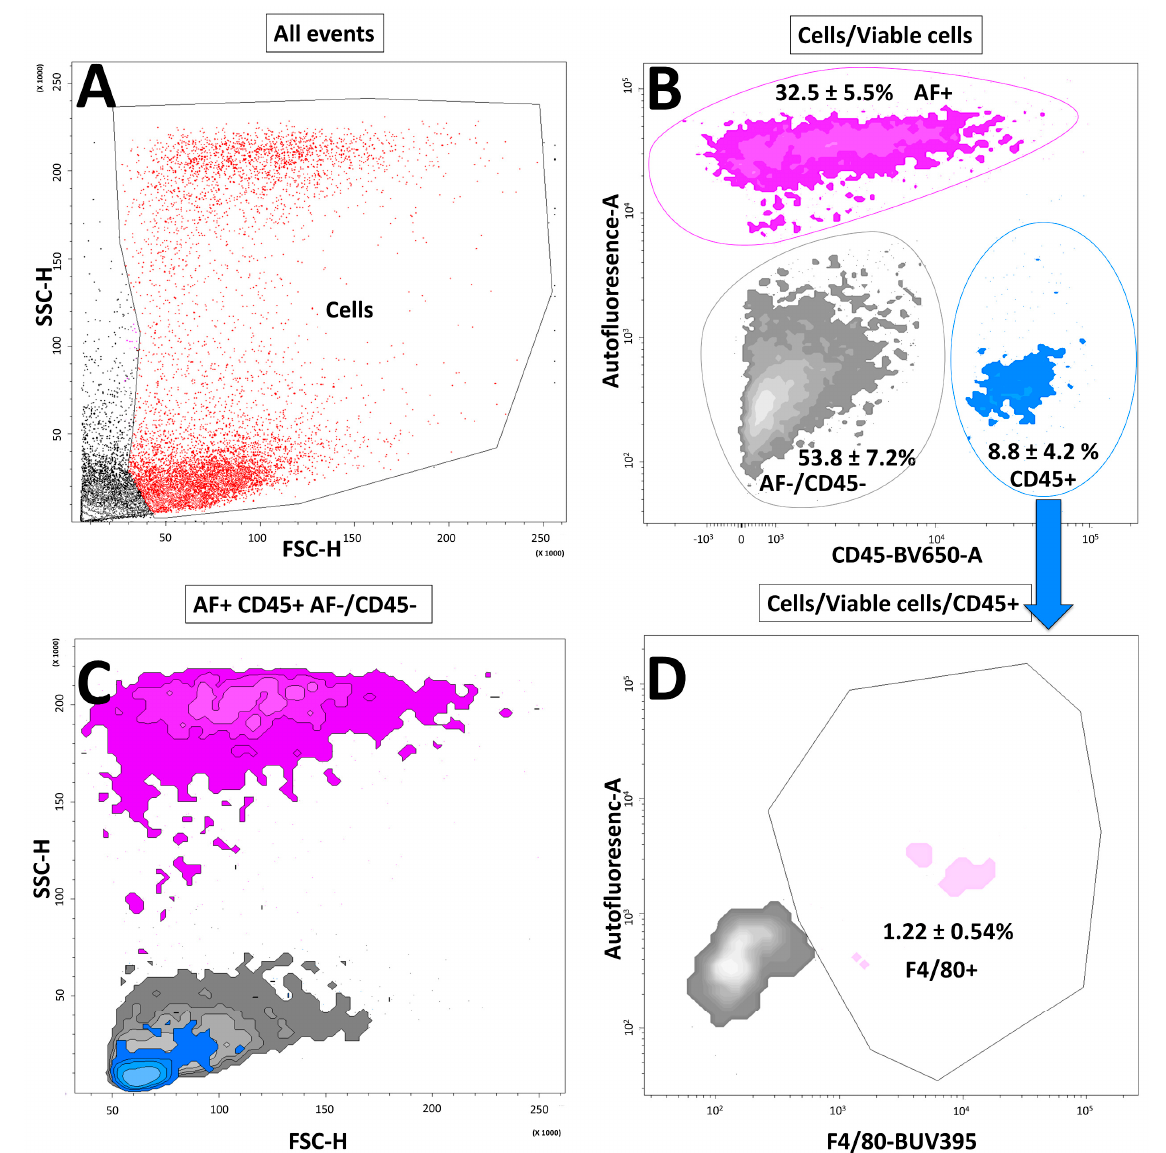
Figure 3. Flow cytometry characterization of isolated hepatic stellate cells. ( A ) Cell morphology allowing to gate cell populations. SSC: side scatter; FSC: forward scatter. ( B ) Selected cells/viable cells (see Figure 1B) gates were analyzed for their expression of CD45 (blue) and the presence of violet-induced autofluorescence (AF) (violet). CD45-/AF- cells are represented in gray. Proportions are expressed as a mean ± SD, n = 3. ( C ) Backgating analysis of the cell population morphology: AF+ cells (violet), CD45+ cells (blue), CD45-/AF- cells (gray). SSC: side scatter,;FSC: forward scatter. ( D ) Expression of F4/80 (pink) among the CD45+ population. Proportions are expressed as a mean ± SD, n = 3.